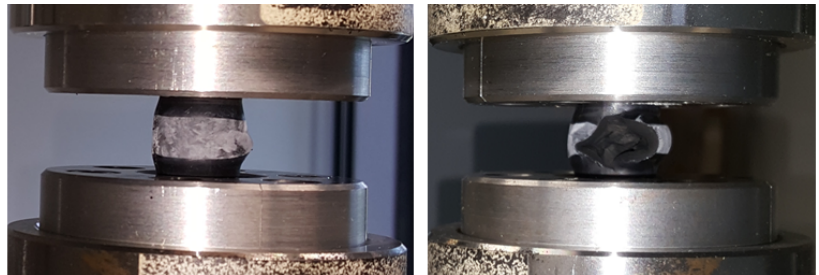
Figure 6. Fatigued dumbbell specimen of filled EPDM rubber, tests were performed with a servo- hydraulic testing machine from INSTRON ( left ) frontside and ( right ) backside.